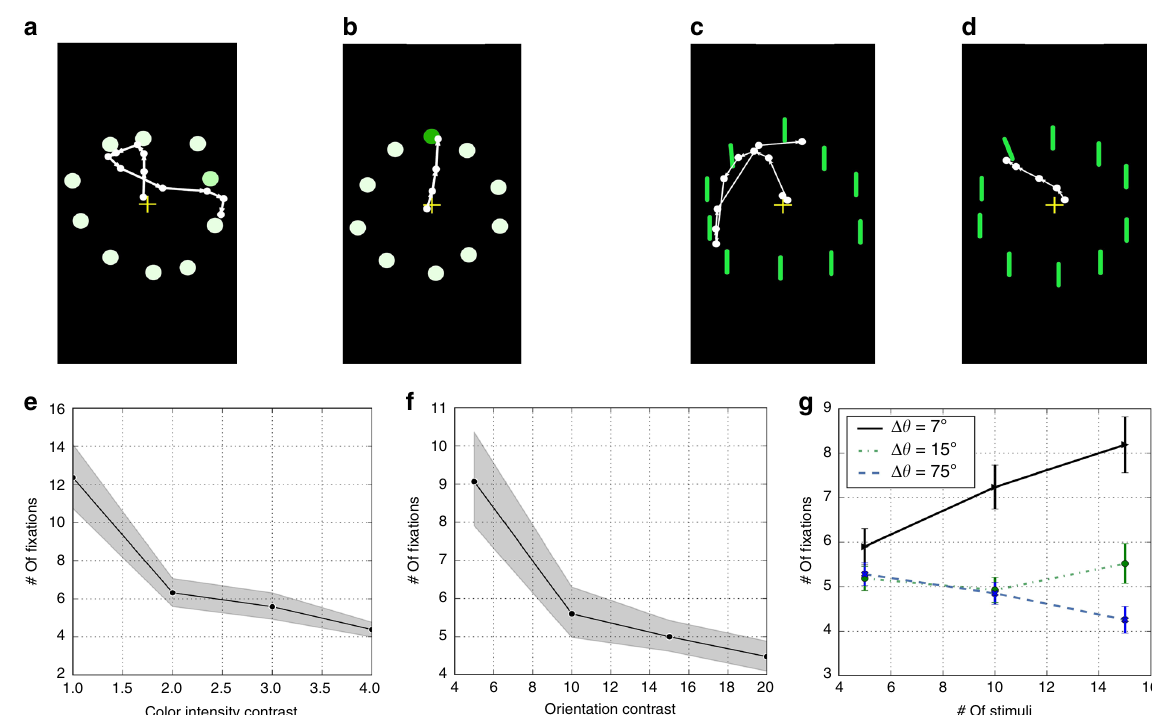
Fig. 4 Smartphone gaze during visual search. a , b , e Effect of target ’ s color contrast on visual search performance. a Gaze scanpath when the target has low contrast (i.e., similar to the distractors). b Scanpath when the target has high contrast (different from the distractors). e Number of fi xations to fi nd the target as a function of target ’ s color contrast (plot shows mean ± s.e.m., n = 44 – 65 trials/contrast-level). c , d , f Similar plots for orientation contrast (difference in orientation between target and distractors in degrees, Δ θ ; n = 42 – 63 trials/contrast-level). g Effect of set size. Number of fi xations to fi nd the target as the number of items in the display varied between 5, 10, and 15; and the target ’ s orientation contrast varied from low ( Δ θ = 7 ∘ ) to medium-high ( Δ θ = 15 ∘ ) to very high ( Δ θ = 75 ∘ ). Plot shows mean ± s.e.m. in number of fi xations ( n = 42 – 63 trials for each combination of set size and Δ θ